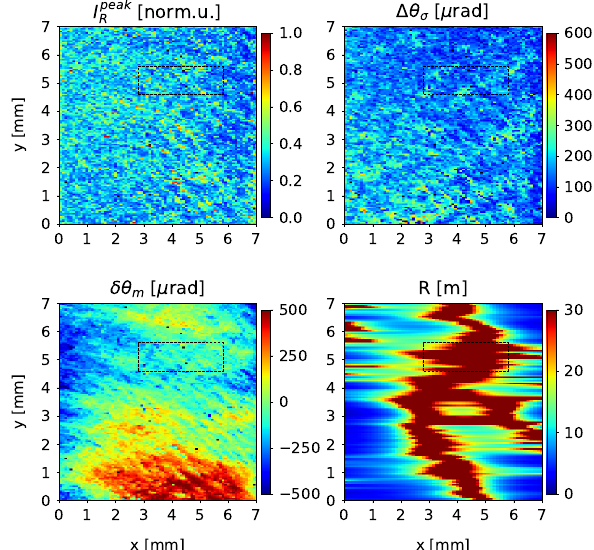
Figure A2. Rocking curve topographs for the (110)-edge oriented diamond crystal plate CVD-I showing maps of peak reflectivity ( I peak , normalized by the maximum value), rocking curve peak position ( δθ m ), R width ( ∆ θ σ ), and the effective radius of curvature R calculated from spline-interpolated δθ m .